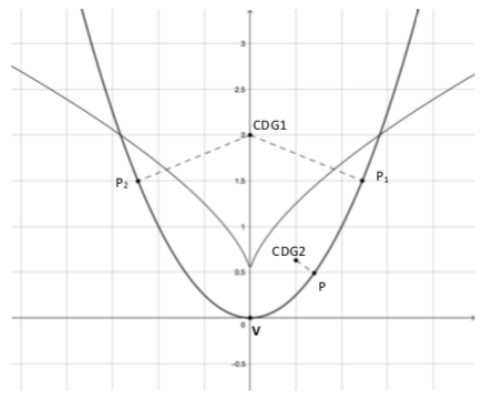
Figure 4. Cusp curve.